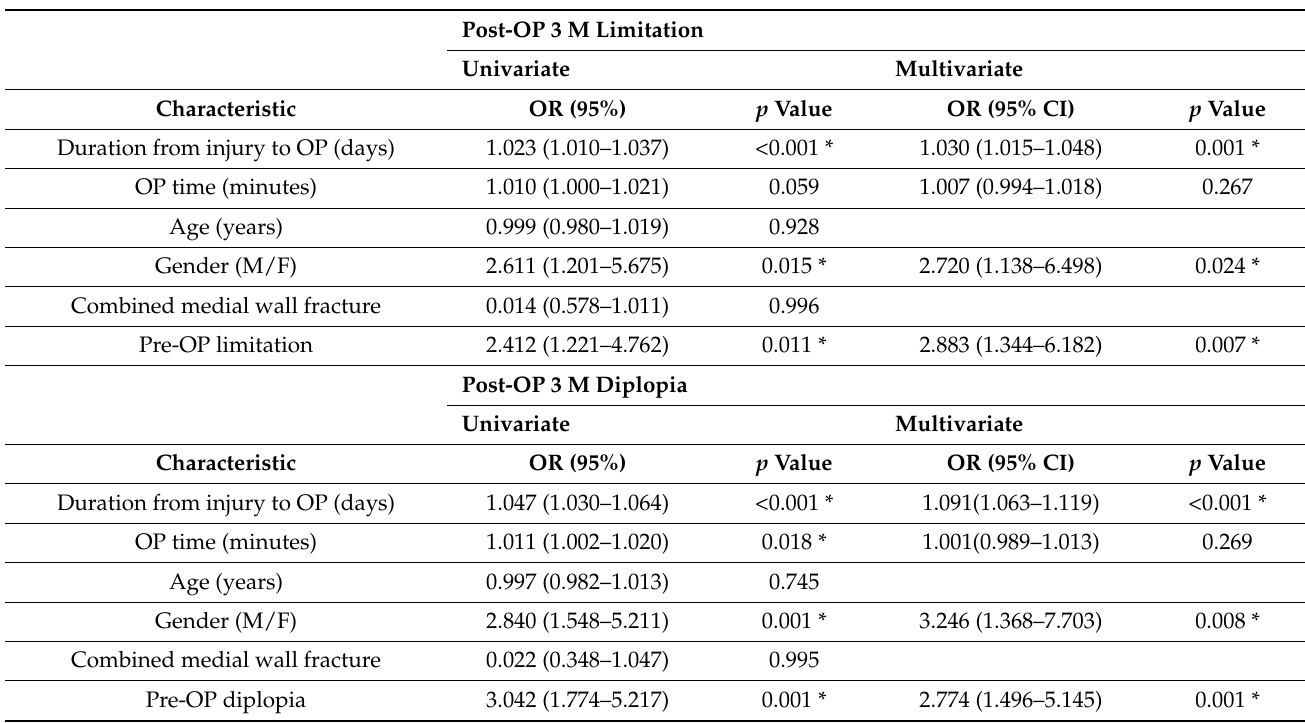
Table 5. Univariate and multivariate regression analyses of baseline characteristics with EOM limitation and diplopia at three months